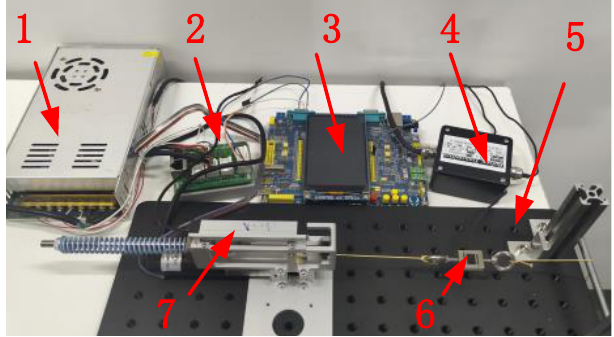
Figure 8. Schematic diagram of experimental platform (1—power supply, 2—motor driver, 3—controller, 4—signal converter, 5—base plate, 6—tension sensor, 7—cable actuator).